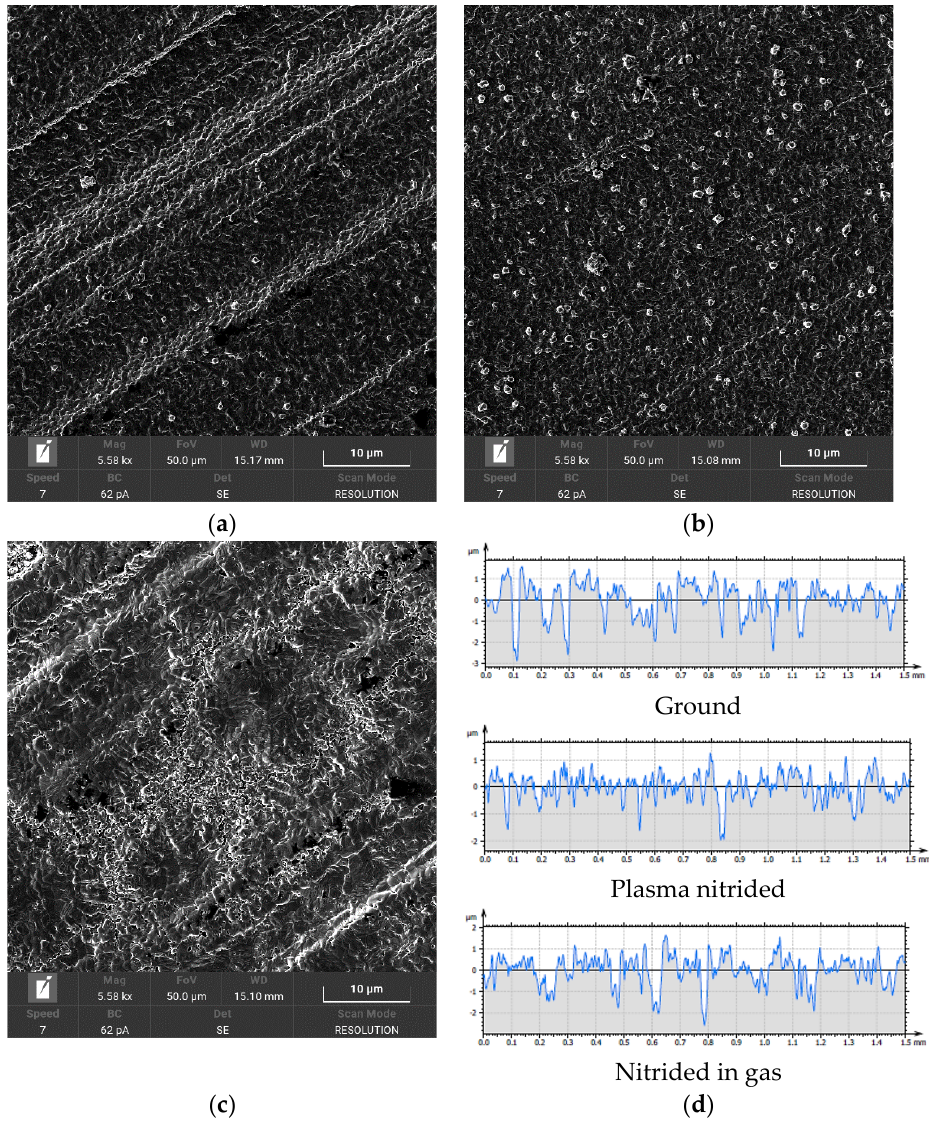
Figure 4. SEM images of the surface of the samples: ( a ) after grinding; ( b ) after plasma nitriding; ( c ) after gas nitriding; ( d ) surface roughness profiles. ( c ) after gas nitriding; ( d ) surface roughness